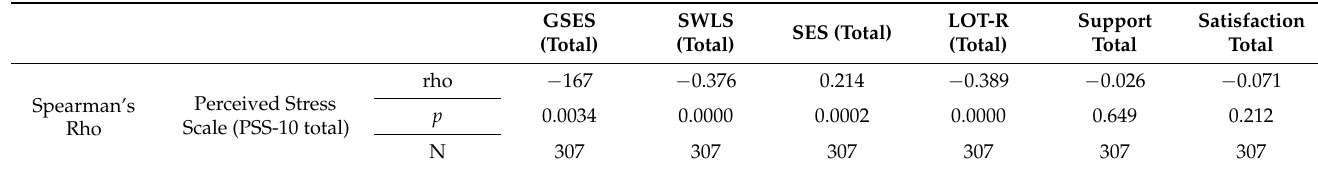
Table 4. Analysis of the correlation between the intensity of stress experienced by the participants and selected psychosocial variables.